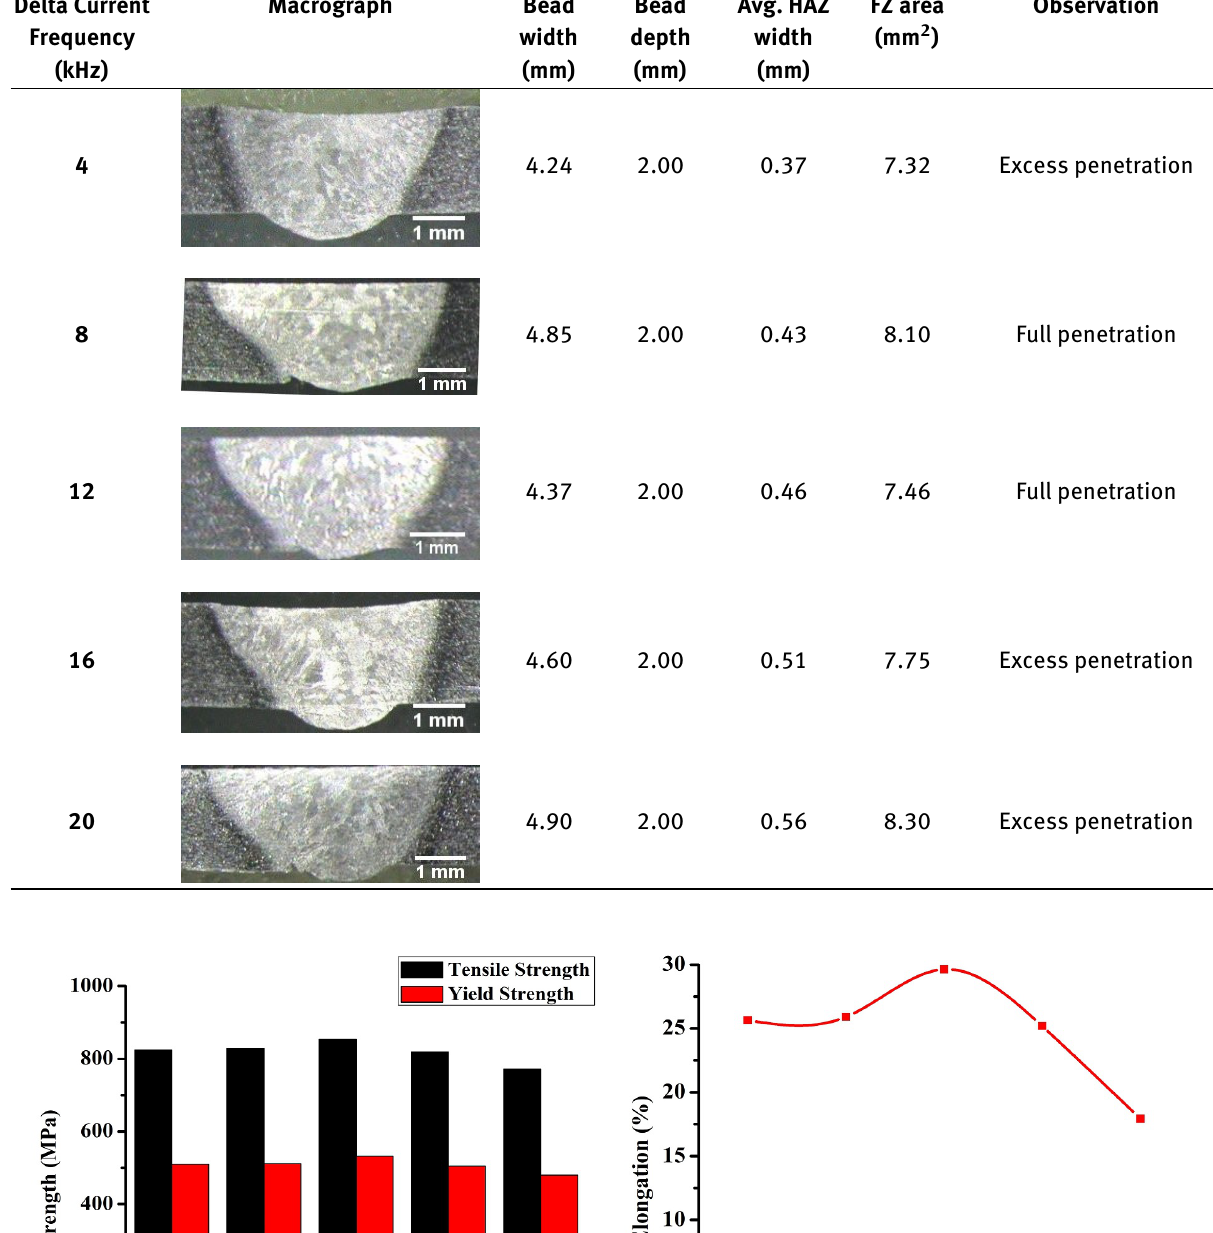
Table 5: Effect of Delta Current Frequency on weld bead geometry Delta Current